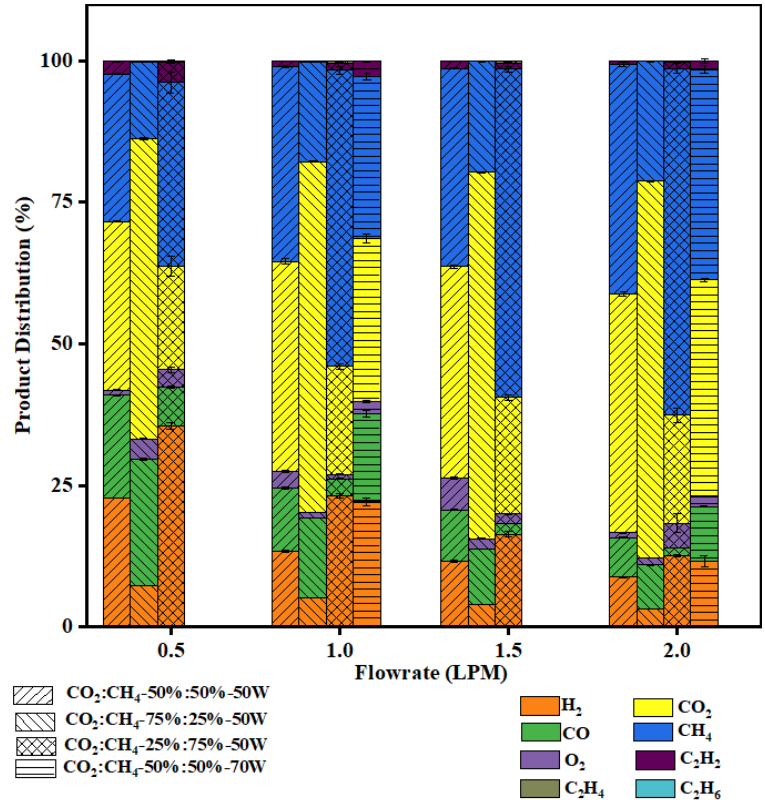
Figure 6. Effect of flow rate on total conversion.